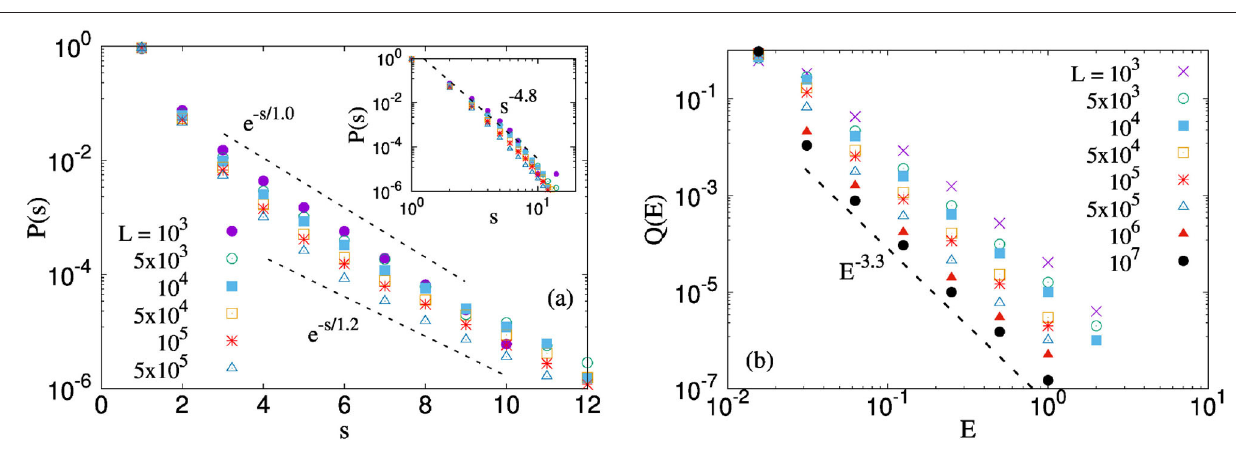
FIGURE 4 | Distribution of energies for an uniform distribution [0:1] and system sizes ranging in between 10 3 and 10 7 . The results are shown for LLS FBM. (a) Avalanche size distribution for LLS FBM is an exponential function: P ( s ) ∼ e − s / s 0 , where s 0 depends weakly on the system size. (b) Scale free distribution for energy emitted: Q ( E ) ∼ E − α , where α is observed to increase slightly with system size.